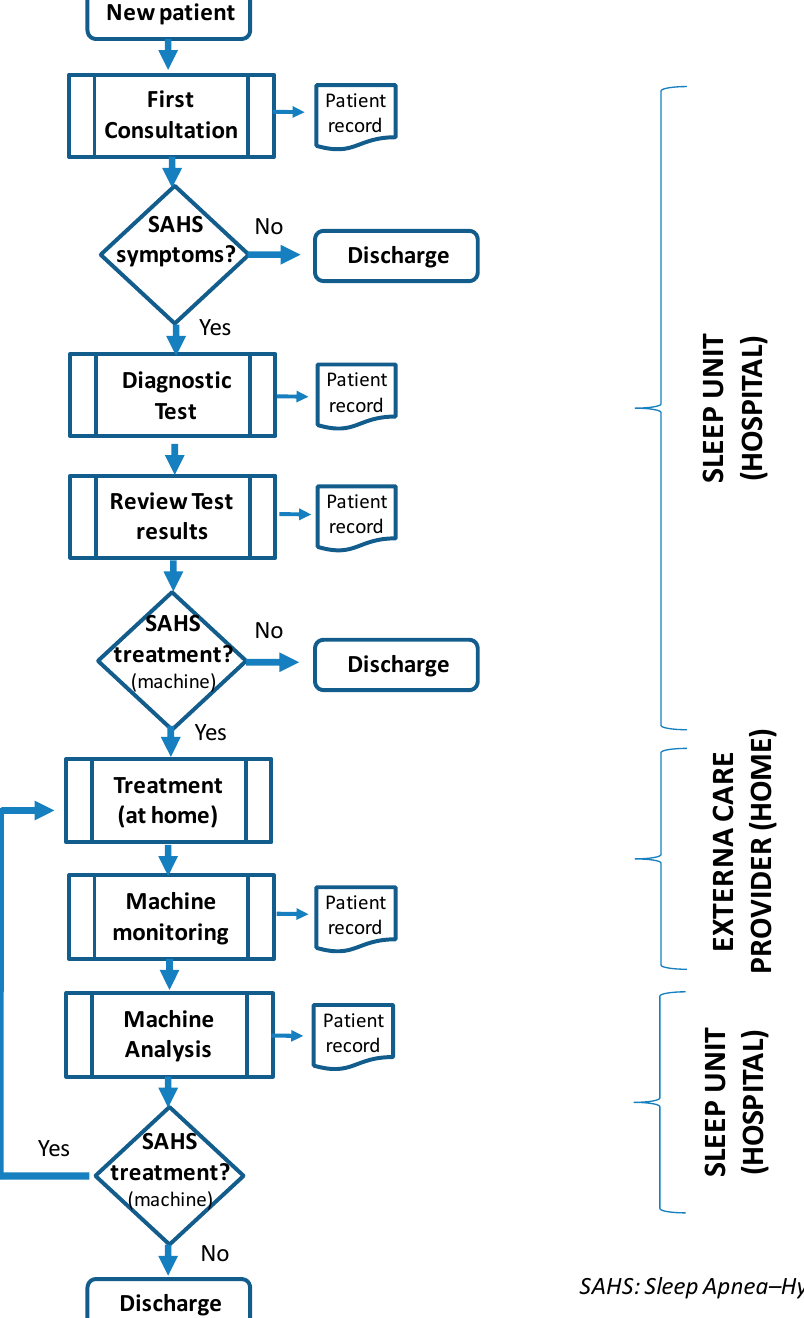
Figure 3. Simplified diagram showing the key processes in patient flow of the sleep unit.